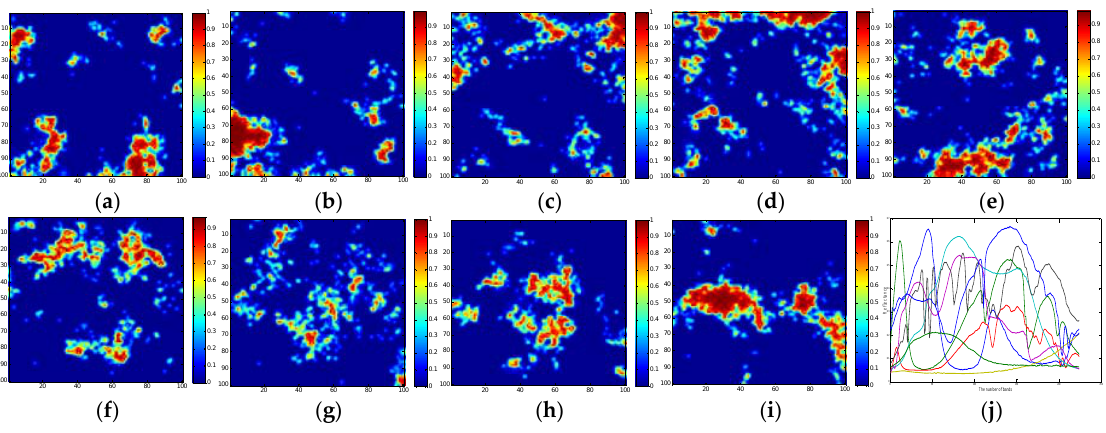
Figure 4. True abundance maps of simulated dataset 2. ( a ) Endmember 1; ( b ) Endmember 2; ( c ) Endmember 3; ( d ) Endmember 4; ( e ) Endmember 5; ( f ) Endmember 6; ( g ) Endmember 7; ( h ) Endmember 8; ( i ) Endmember 9; and, ( j ) Spectral signatures.